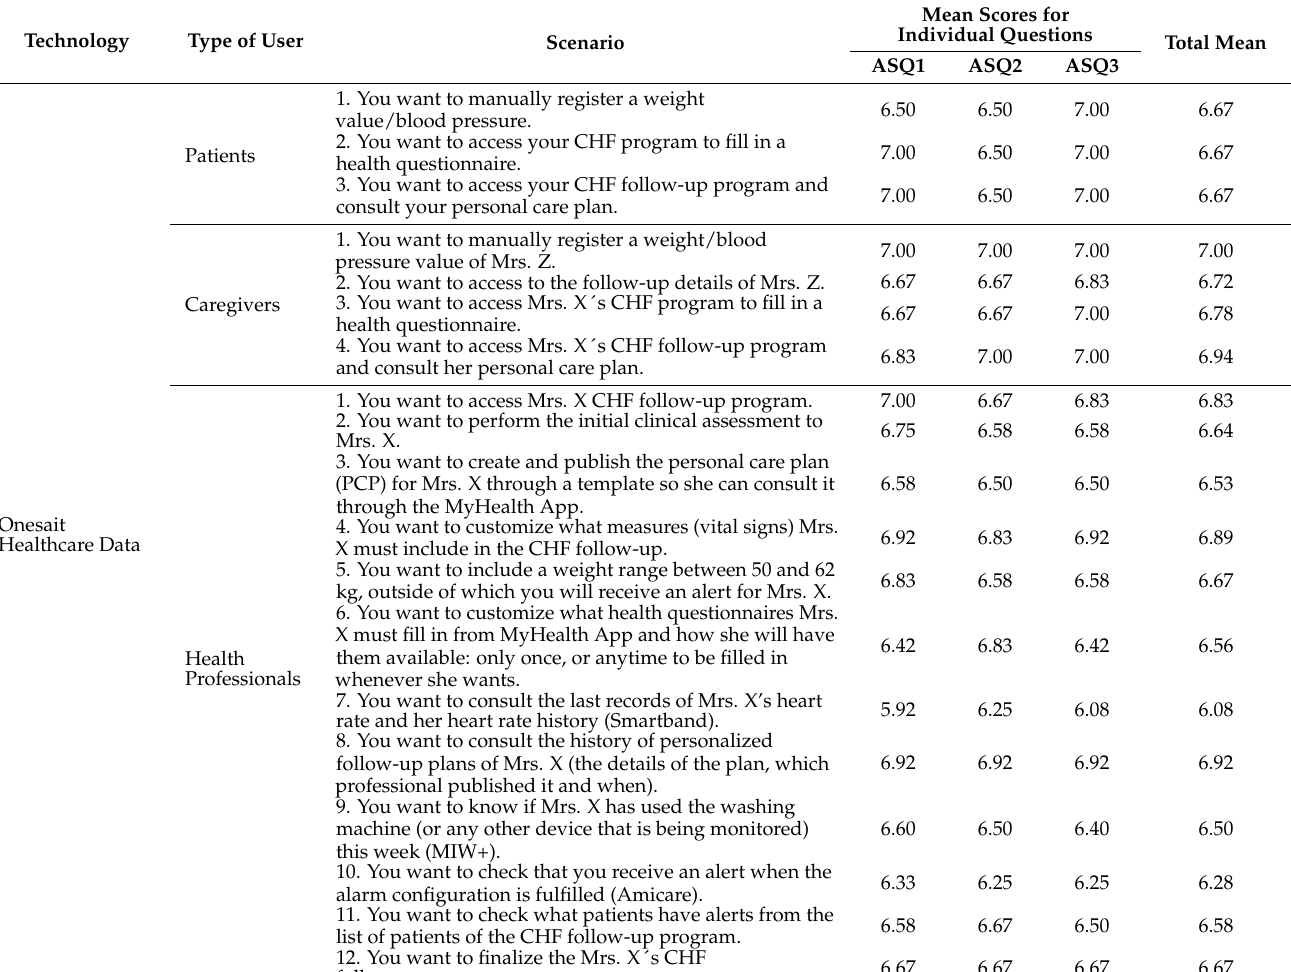
Table 12. ASQ mean scores for Onesait Healthcare Data with the integrated technologies during the pre-validation phase 2.